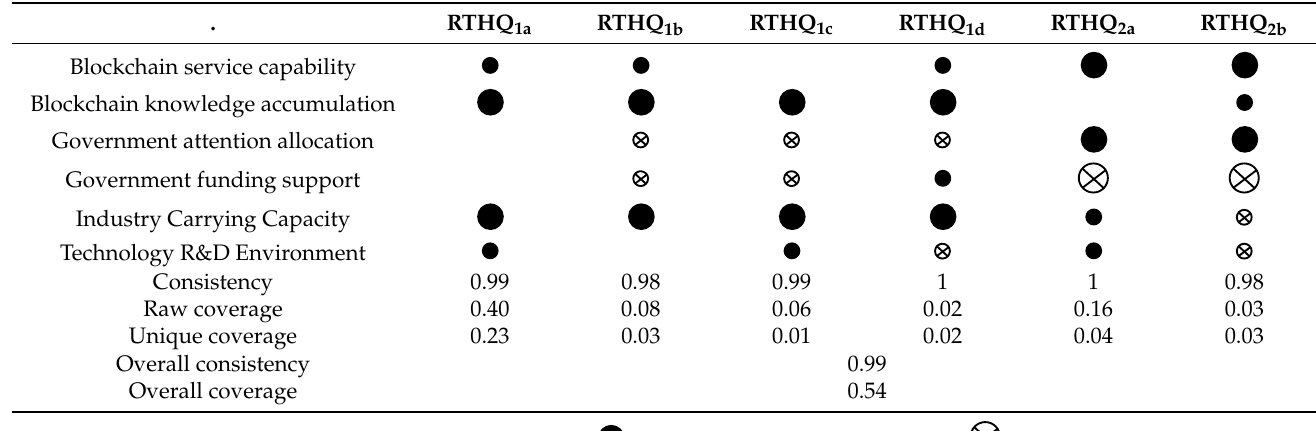
Table 8. Results of the robustness test with alternative crossover points. Note: Large, full black circle “ ” (present) and large, cross open circle” ”(absence) represent core conditions. Small, full black ” ”(present) and small, crossed open circles ” ”(absence) represent peripheral conditions. For high-quality solutions, RTHQ1a, RTHQ1b, RTHQ1c, and RTHQ1d, which can be represented by the knowledge-industry-driven path; RTHQ2a and RTHQ2b can be represented by the government-service-driven path.